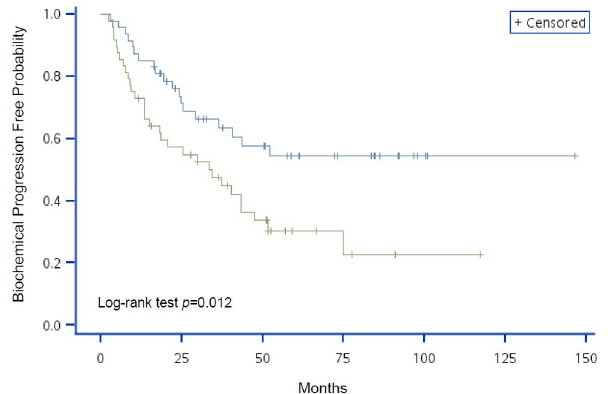
Figure 1. Kaplan-Meier analysis of BCP-free probability for advanced prostate cancer patients by risk group using initial PSA. The blue line represents the low initial PSA group (PSA , 106 ng/ mL) and the green line represents the high initial PSA group (PSA $ 106 ng/mL). P -value of Log-rank test , 0.001.